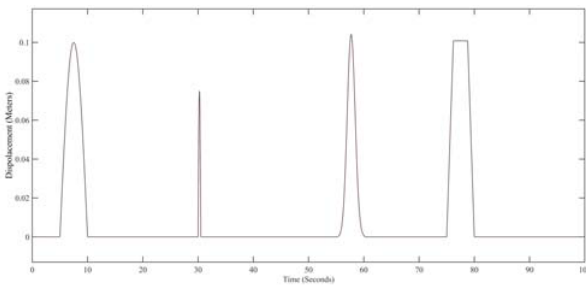
Figure 19. Road profile Overall